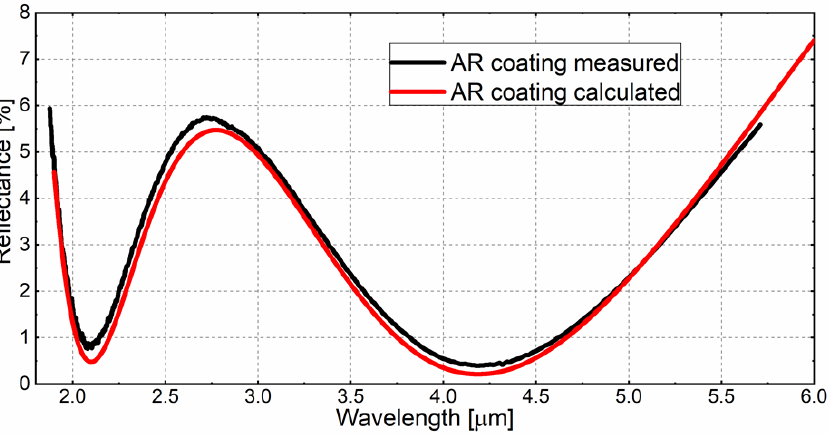
Figure 7. Reflection spectra of AR coating (ZnSe/Al 2 O 3 ): red — calculated in Optilayer; black — meas-